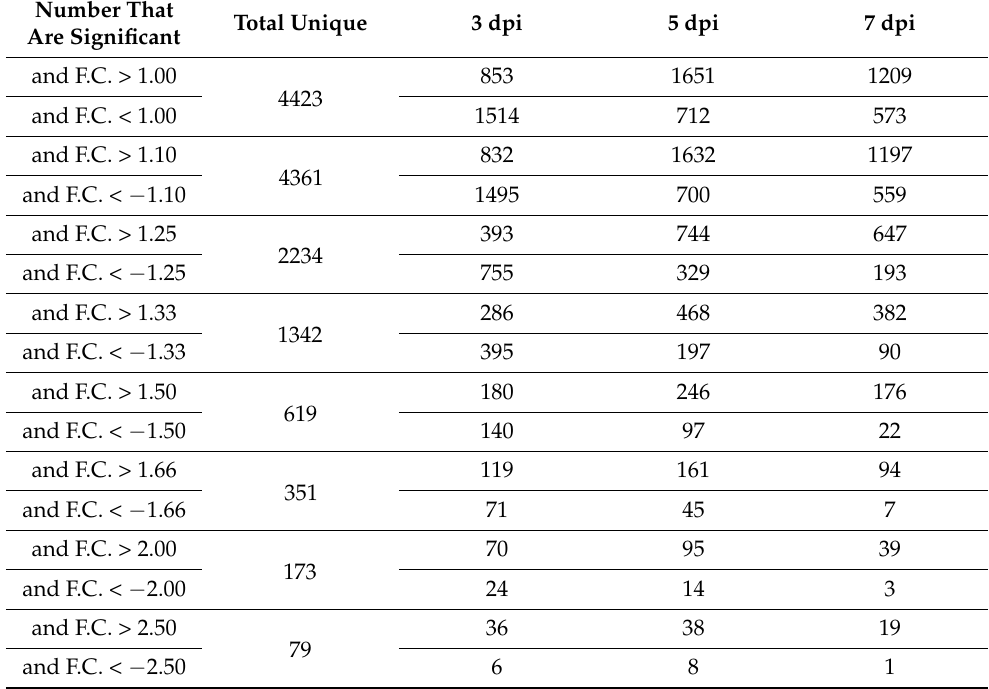
Table 1. Numbers of significantly affected ZIKV-infected Sertoli